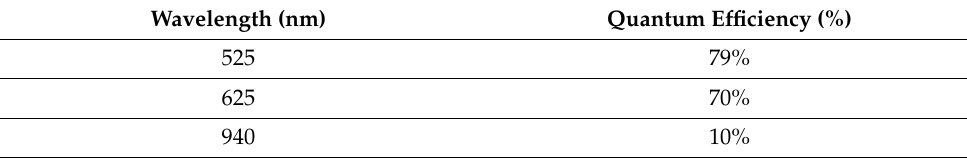
Table 3. Quantum efficiency of the BFS-U3-28S5M-C camera, according to